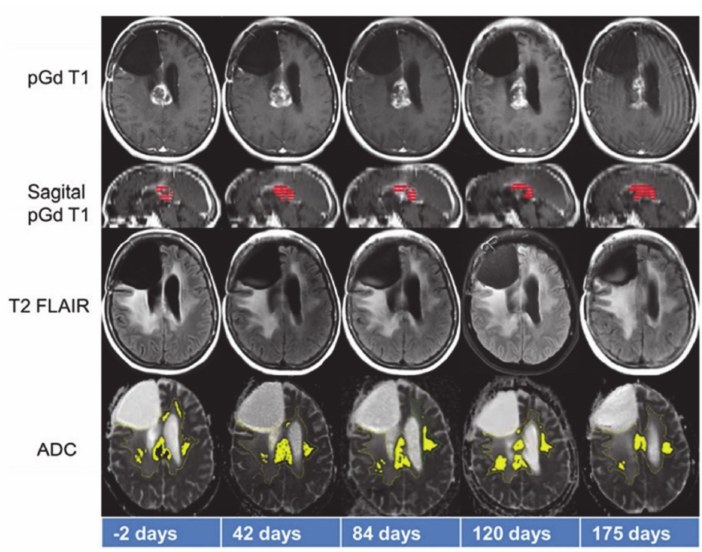
Figure 6. Representative anatomical images and apparent diffusion coefficient (ADC) maps from a patient who benefitted from treatment with anti-PD1 immunotherapy. While tumor volume on sagittal post-contrast T1 weighted images (red color) demonstrated initial declining trends from day 42–84, it increased from day 120–175. On the other hand, tumor volume as measured by considering that ADC values on the ADC maps (yellow color) decreased between day 120–175, indicating positive response. Reprinted with permission from ref. [95]. Copyright 2017 Springer- Verlag Berlin